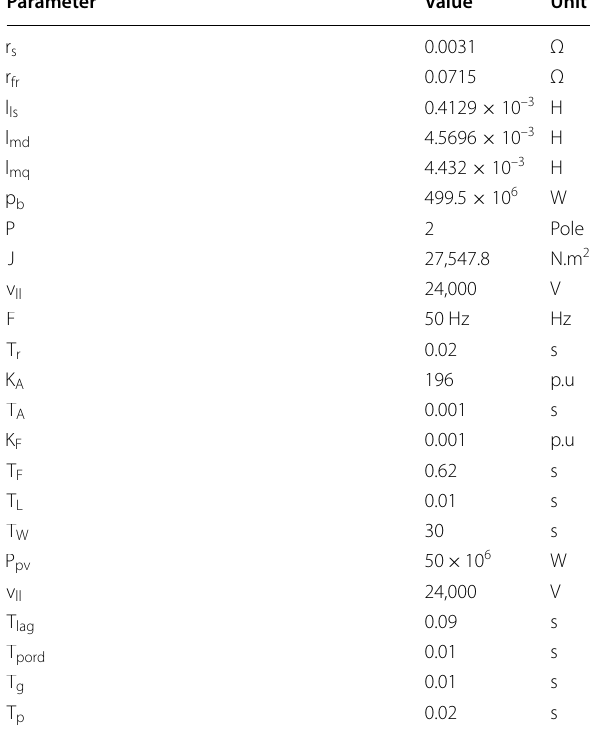
illustrate the good damping of the electromechanical modes using PDC.